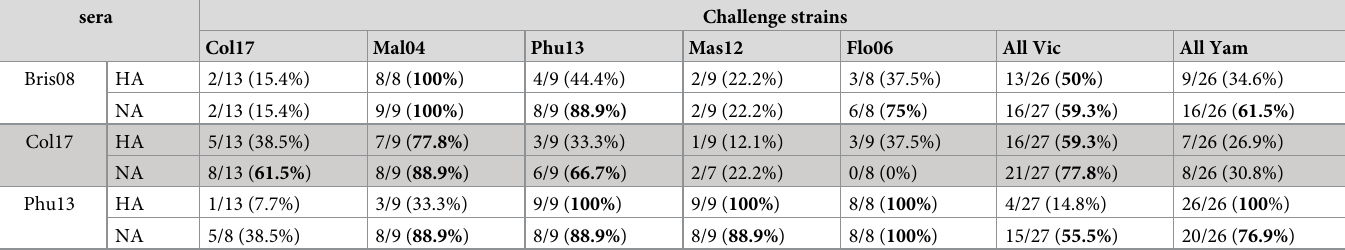
Table 1. Survival of mice that received anti-HA or -NA serum after challenge with RG Yamagata or Victoria viruses.